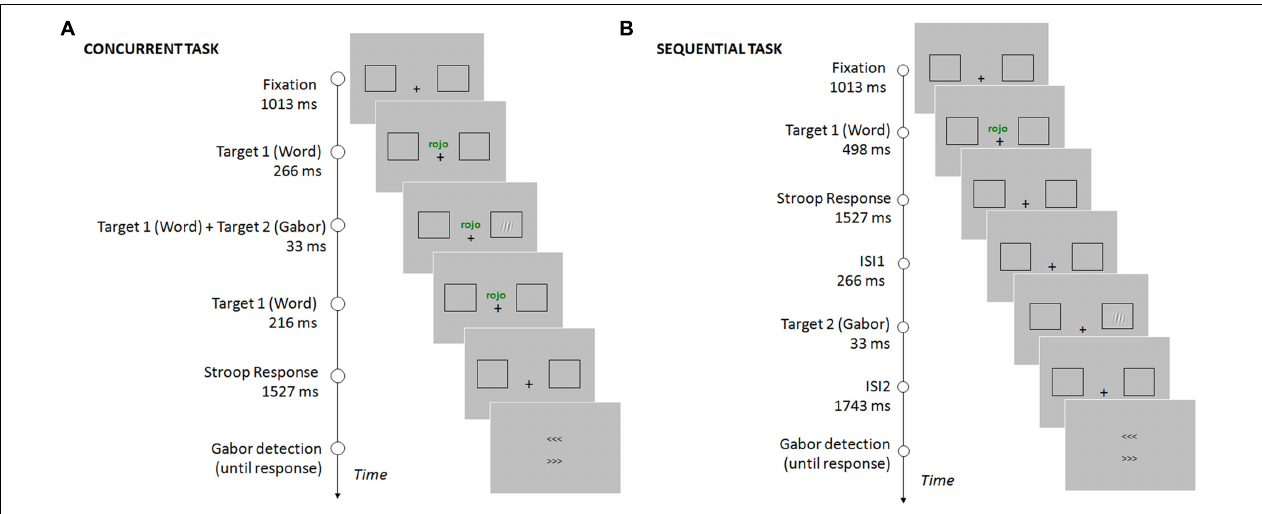
FIGURE 1 | Timing and sequence of the stimuli on a given trial for the concurrent task (A) and the sequential task (B) . In the concurrent task, the Gabor was presented while the word (Stroop stimulus) was still on the screen. Participants had to report the color of the ink in which the word was written, and then report the location of the Gabor using the arrows (see Procedure). In the sequential task, participants first responded to the word (Stroop stimulus), and the Gabor was presented after the response to the Stroop task was completed. The location of the Gabor was reported using the arrows (see Procedure).